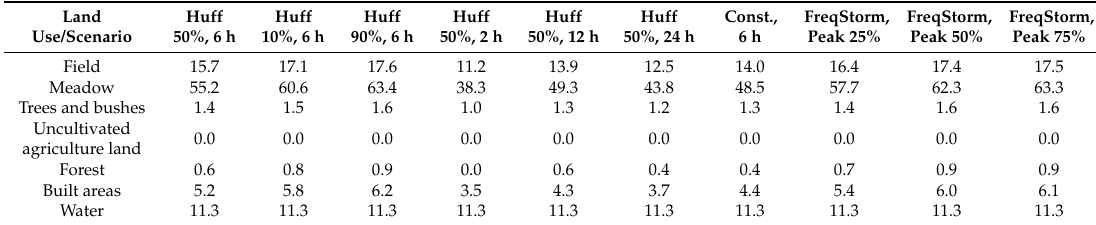
Table 4. Area (10 3 m 2 ) of flooded land use types for 10 scenarios for the 10-year return period. Land Use/Scenario